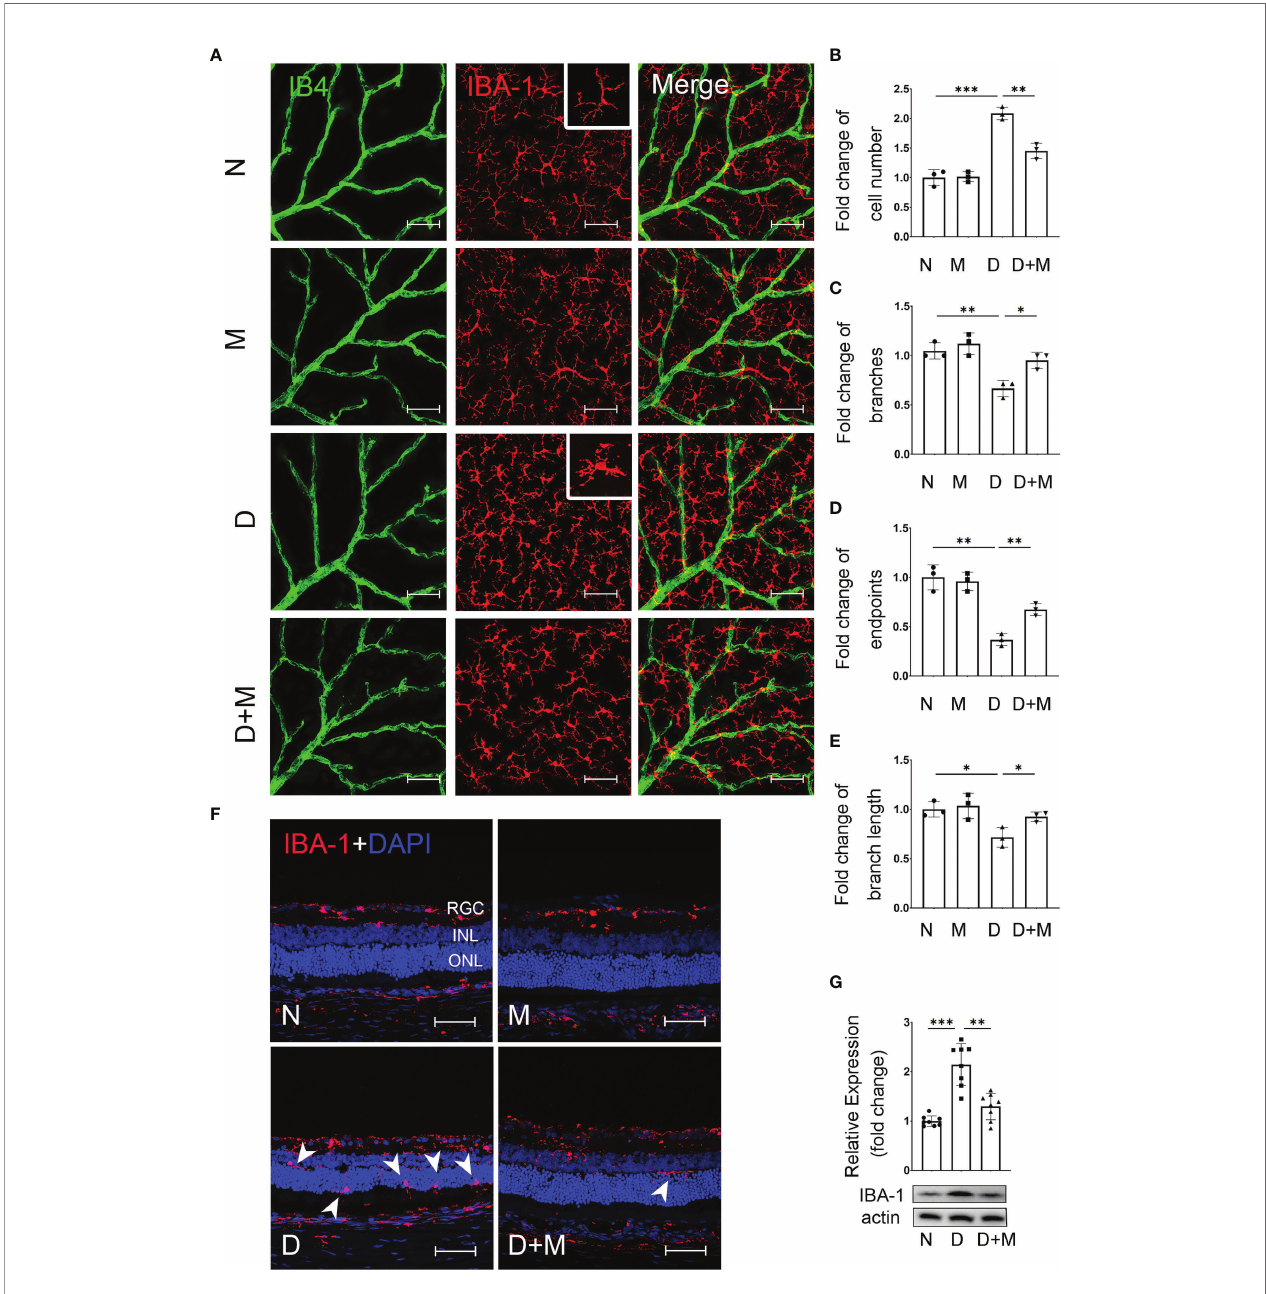
FIGURE 2 | Melatonin inhibits microglial activation in diabetic rat retinas. (A) Representative images of IBA-1 (red) and IB4 (green) immunolabeling in super fi cial capillary plexus of the retinal fl atmounts in normal control and diabetic rat retinas with or without melatonin treatment. (B – E) Comparison of morphological changes in microglial number, cell branches, cell endpoints, and cell branch length in normal control and diabetic rat retinas with or without melatonin treatment. (F) Representative images of IBA-1 (red) and DAPI (blue) immunolabeling of retinal cryosections in normal control and diabetic rat retinas with or without melatonin treatment. Microglial migration is indicated by white arrowheads (n = 3 retinas per group). (G) IBA-1 protein expression in normal control and diabetic rat retinas with or without melatonin treatment. Data are expressed as mean ± SEM (n = 8 retinas per group). N, normal control group; M, melatonin treatment group; D, diabetes group; D+M, diabetes with melatonin treatment group; *p < 0.05, **p < 0.01, ***p < 0.001 by one-way ANOVA. Scale bar, 50 m